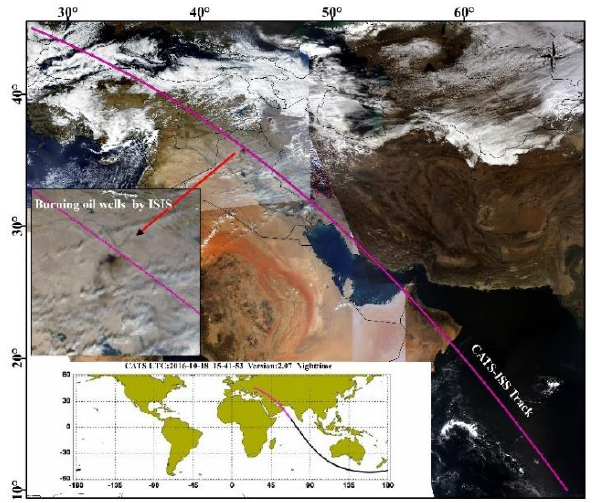
Figure 1. The study overpass of CATS-ISS Research is carried out in three main stages. Flowchart is shown in the Fig.2